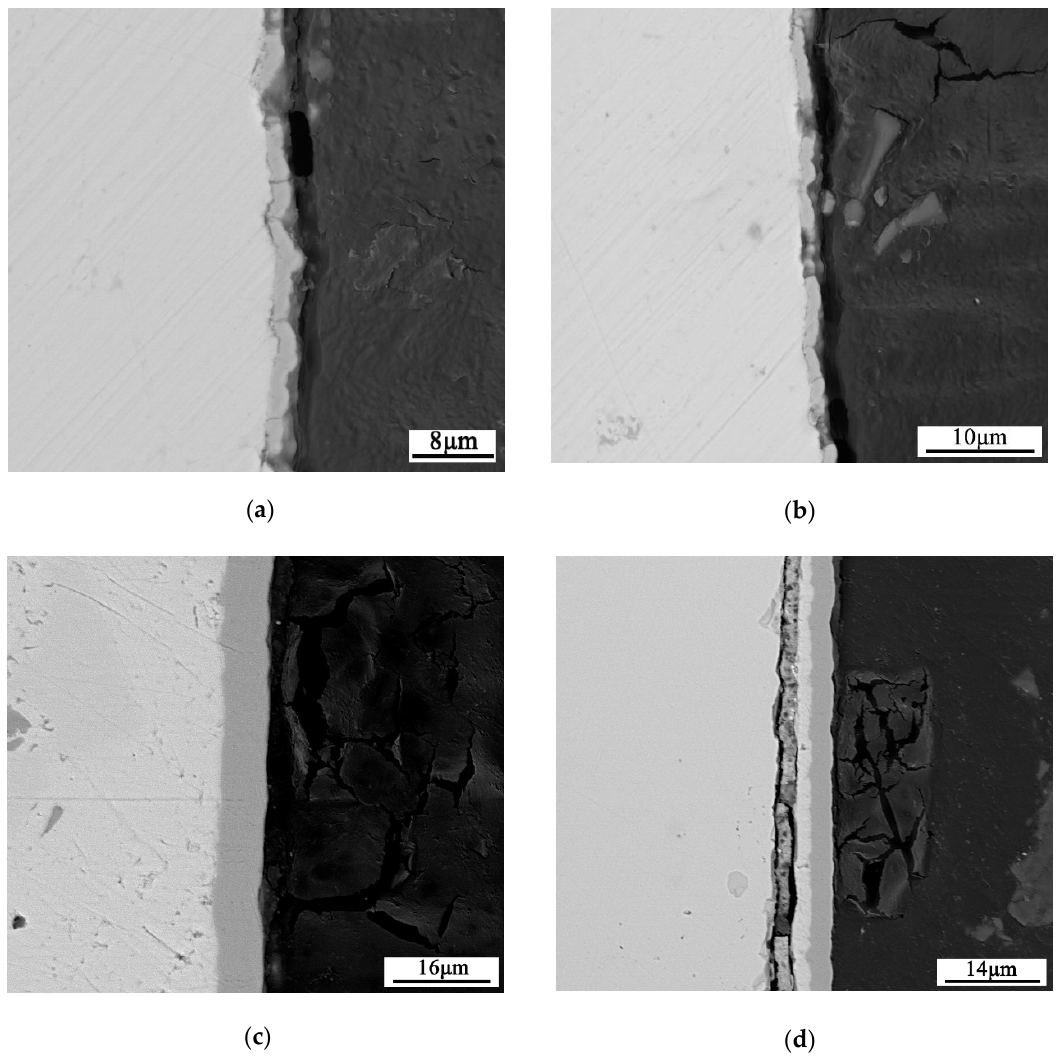
Figure 4. The cross-sectional BSE micrograph of the Co-x wt % Mo / SKU interface: ( a ) x = 50, ( b ) x = 40, ( c ) x = 35, ( d ) x = 25. No cracks were found either in the annealed layer or the skutterudite compound when x = 35.